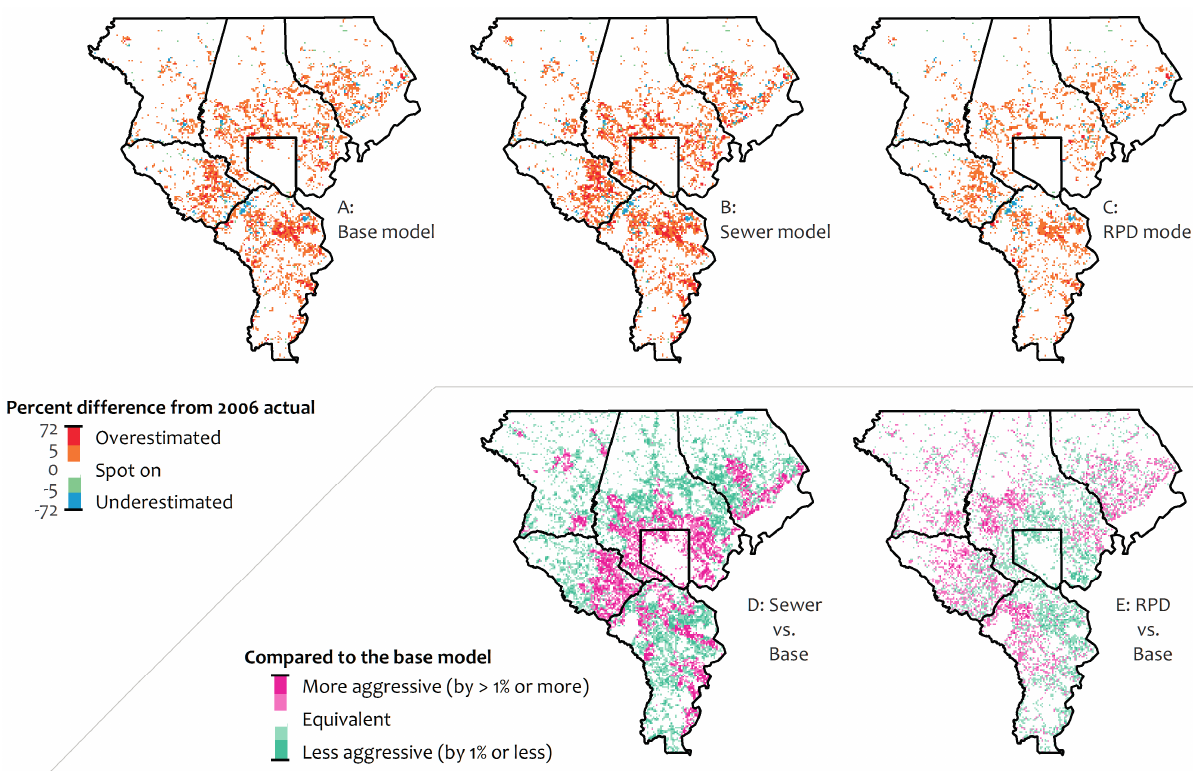
Figure 6. Upper panel ( A – C ) shows maps of difference in % urban per 480 m cell (modeled—observed); Lower panel ( D , E ) compares the mapped results from the three exclusion/attraction layers.